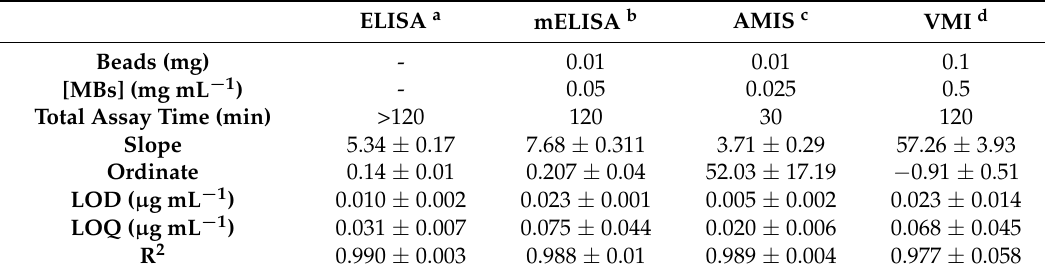
a Enzyme-Linked Immunosorbent Assay; b Magnetic Enzyme-Linked Immunosorbent Assay; c Amperometric Magneto-Immunosensor; d Voltamperometric